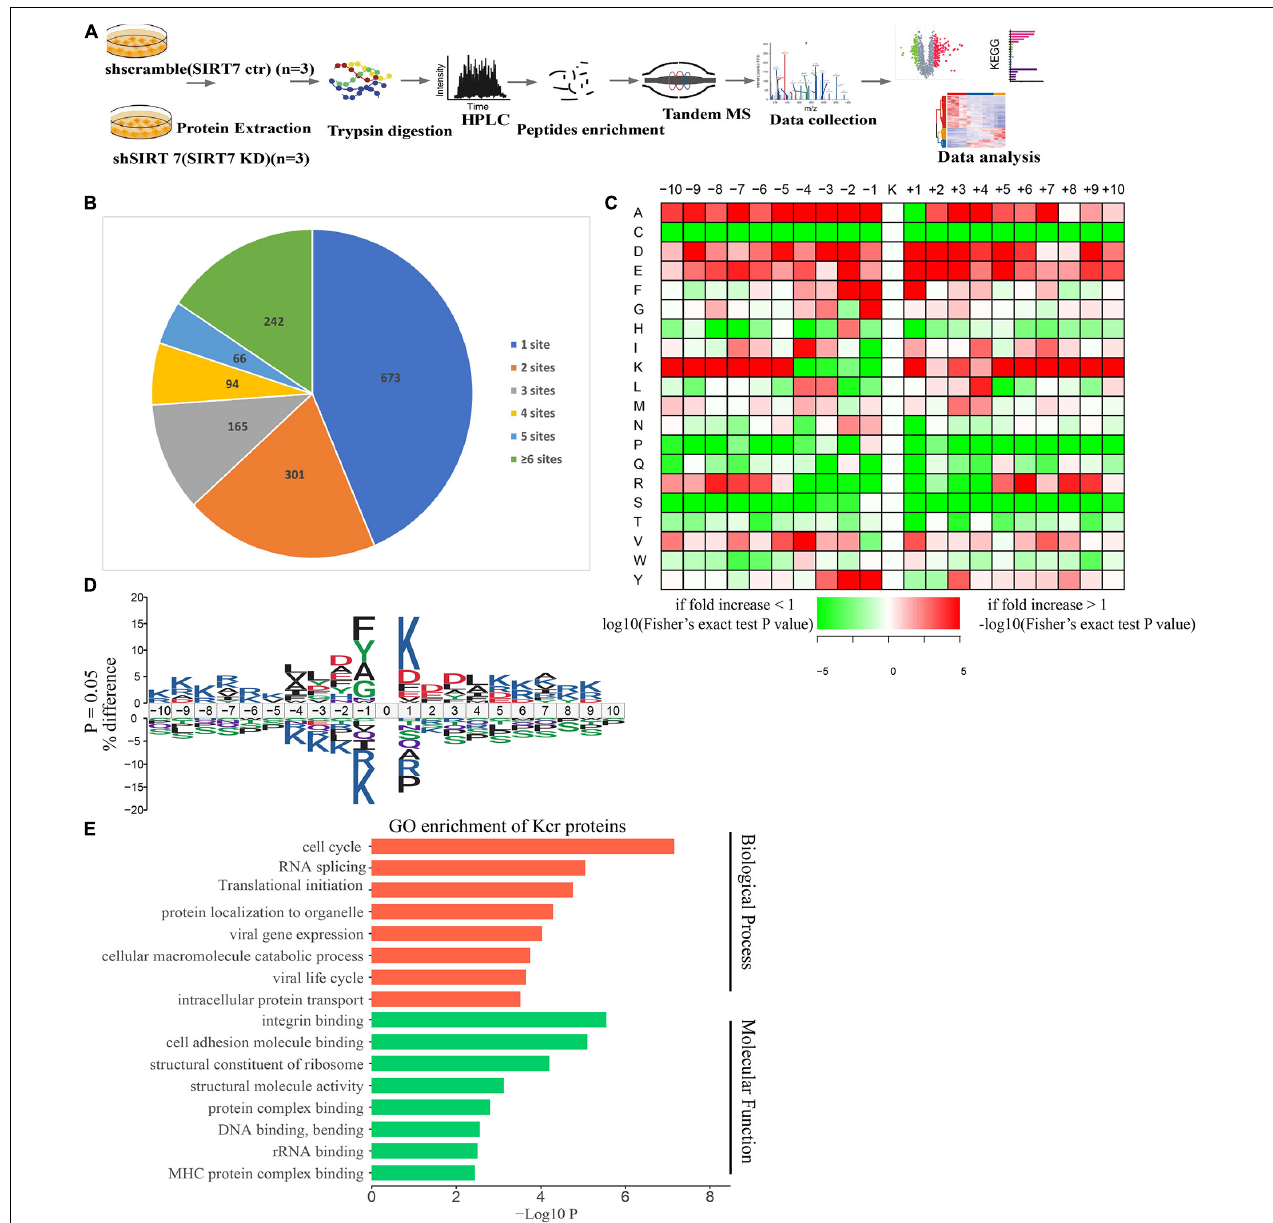
FIGURE 4 | Profiling Kcr proteome in senescence 2BS fibroblast. (A) Schematic diagram of the experimental workflow for identification of protein Kcr in WT and SIRT7 KD senescence 2BS fibroblast. (B) Pie chart showing the distribution of the number of identified Kcr sites per protein. (C) Motif analysis of all identified Kcr proteins. (D) IceLogo representation showing flanking sequence preferences for all Kcr sites. (E) Bar graphs showing representative ontology annotations enriched with Kcr